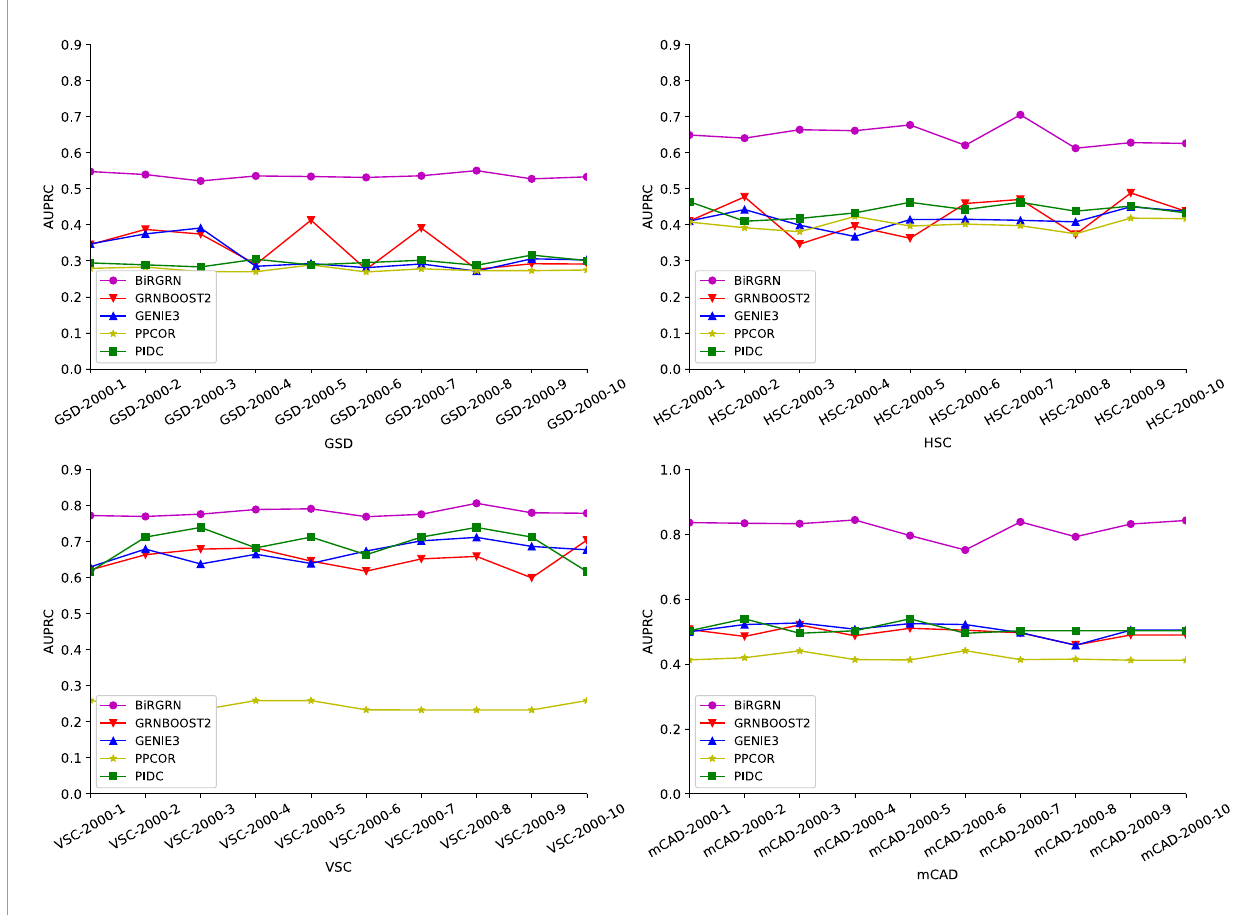
FIGURE 4 | AUPRC scores of of the compared GRN inference algorithms on four simulated datasets.